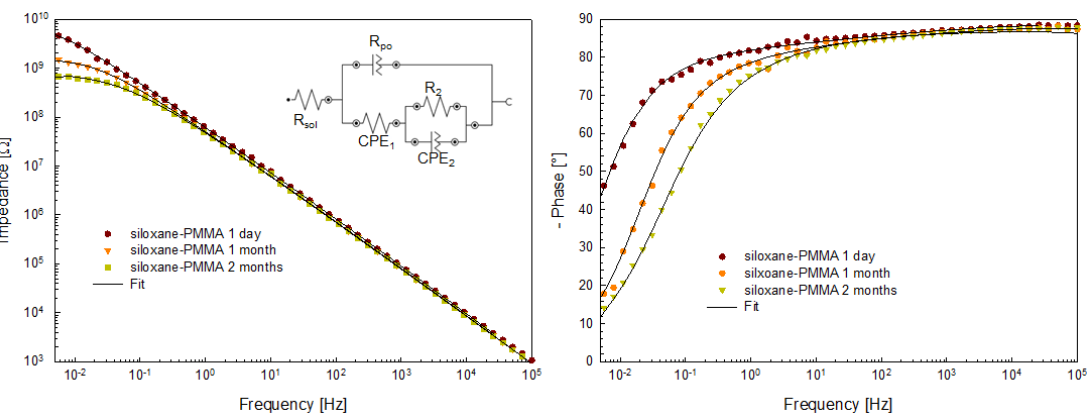
Figure 8. Bode plots of impedance magnitude and phase angle of bare AA7075-T6, and AA7075-T6 coated with siloxane-PMMA and of siloxane-PEMA coatings measured after immersion in 0.1 M NaCl for 1 day.